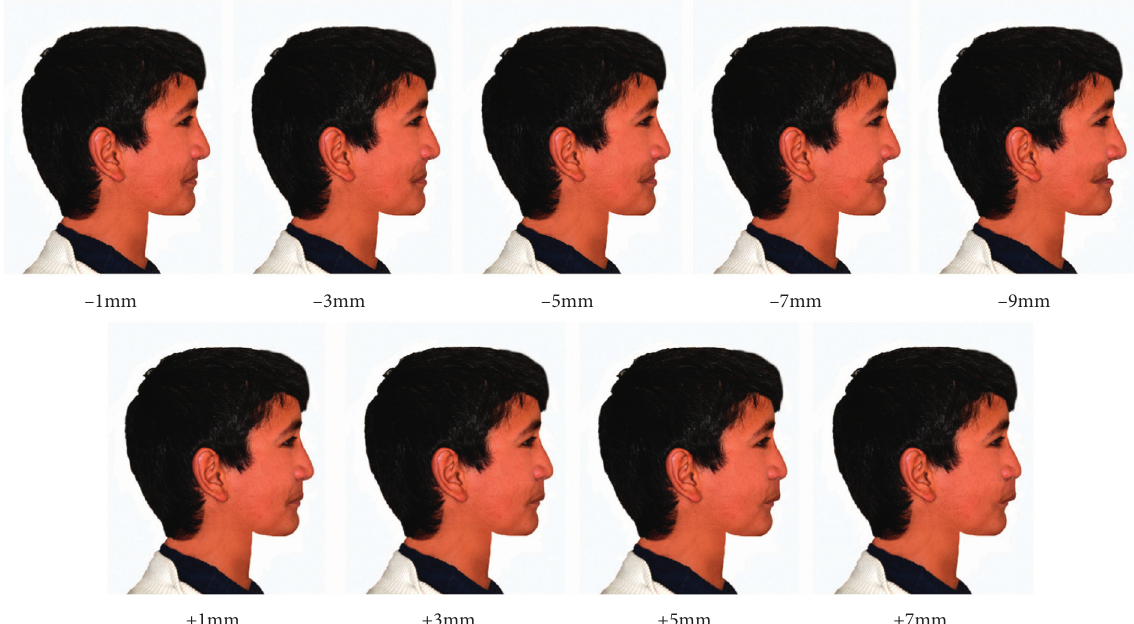
Figure 2: The manipulated profile images to affect maxillary retrusion and protrusion based on relation of the A ∗ point to the TVL.